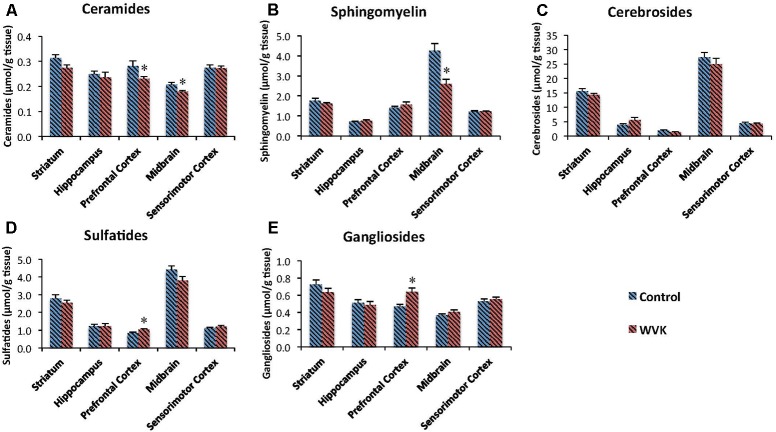
Effect of WVK treatment on sphingolipid profile in different brain regions in C and WVK groups. Figures show (A) ceramides; (B) sphingomyelin; (C) cerebrosides; (D) sulfatides; (E) gangliosides in striatum, hippocampus, prefrontal cortex, midbrain, and sensorimotor cortex. Values are mean ± SEM, n = 6–7 rats per group. Differences between brain regions were analyzed within C and WVK groups by one-way ANOVA, followed by Tuckey’s post hoc test. [Sphingomyelin C: F(4,30) = 50.69, p < 0.0001; WVK: F(4,29) = 8.76, p < 0.0001. Cerebrosides C: F(4,30) = 149.3, p < 0.0001; WVK: F(4,29) = 89.33, p < 0.0001. Sulfatides C: F(4,30) = 107.8, p < 0.0001; WVK: F(4,29) = 75.12, p < 0.0001. Ceramide C: F(4,25) = 8.95, p < 0.0001; WVK: F(4,24) = 5.19, p < 0.001. Gangliosides C: F(4,30) = 13.8, p < 0.0001; WVK: F(4,30) = 6.6, p < 0.05]. Group differences within a given brain region were analyzed by Student’s unpaired t-test. Statistically different from control group, ∗p < 0.05.